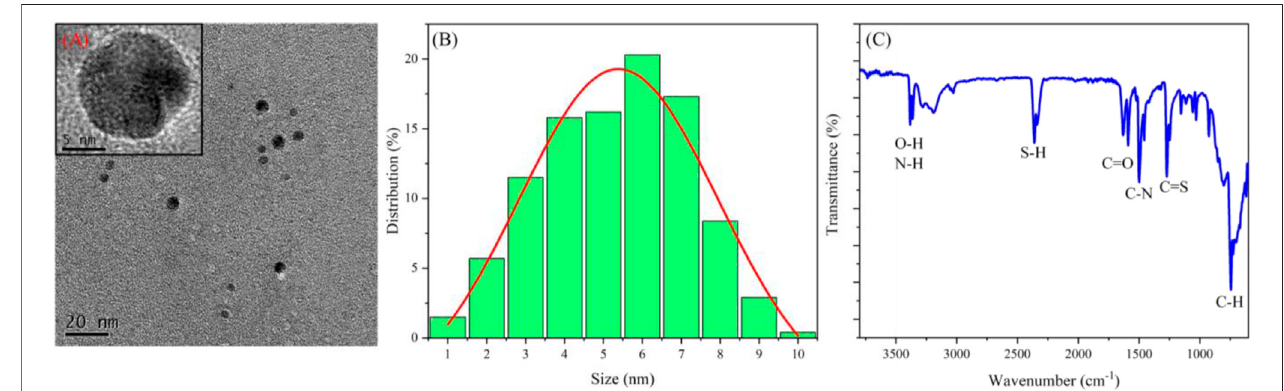
FIGURE 2 | High-resolution XPS spectra of C 1s (A) , N 1s (B) , O 1s (C) , and S 2p (D) .